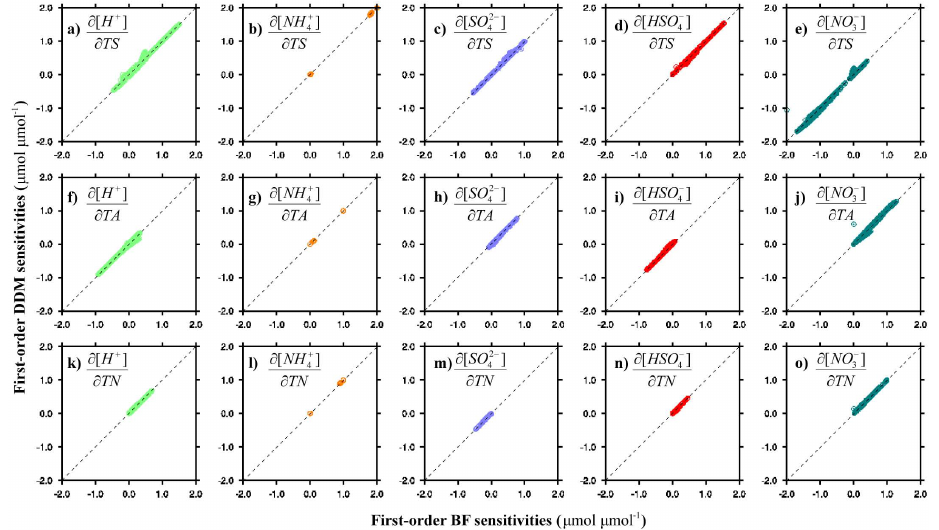
, HSO 4 − , and NO − ) 4 3